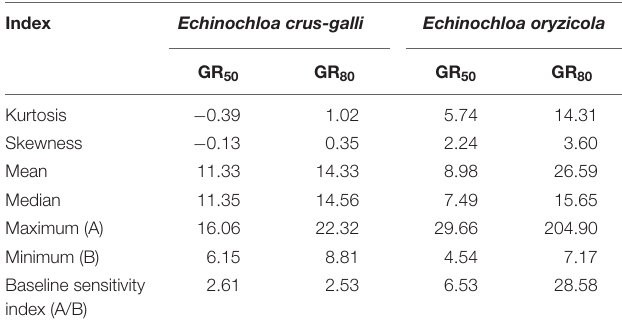
TABLE 1 | Summary of distribution analysis and baseline sensitivity in GR 50 and GR